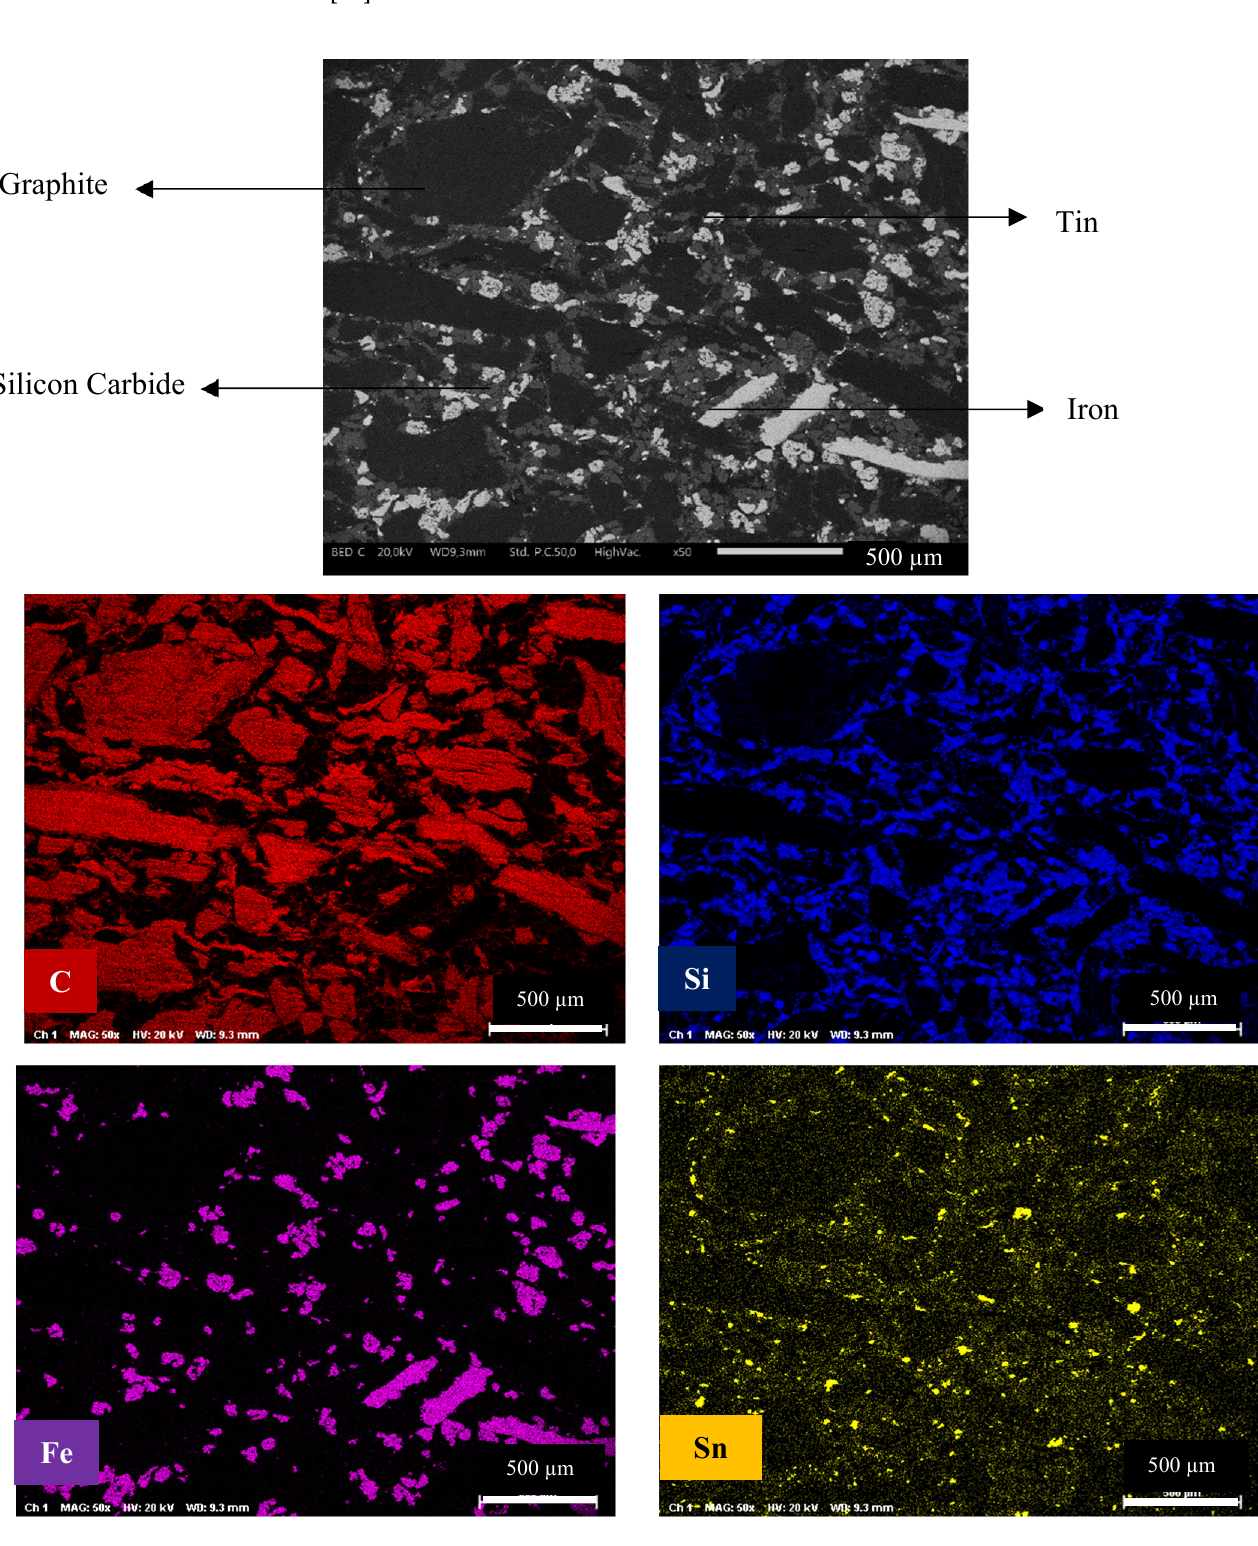
Figure 1. SEM BSE image of the cross-section of the SiC-graphite composite material. The corresponding maps are also shown.